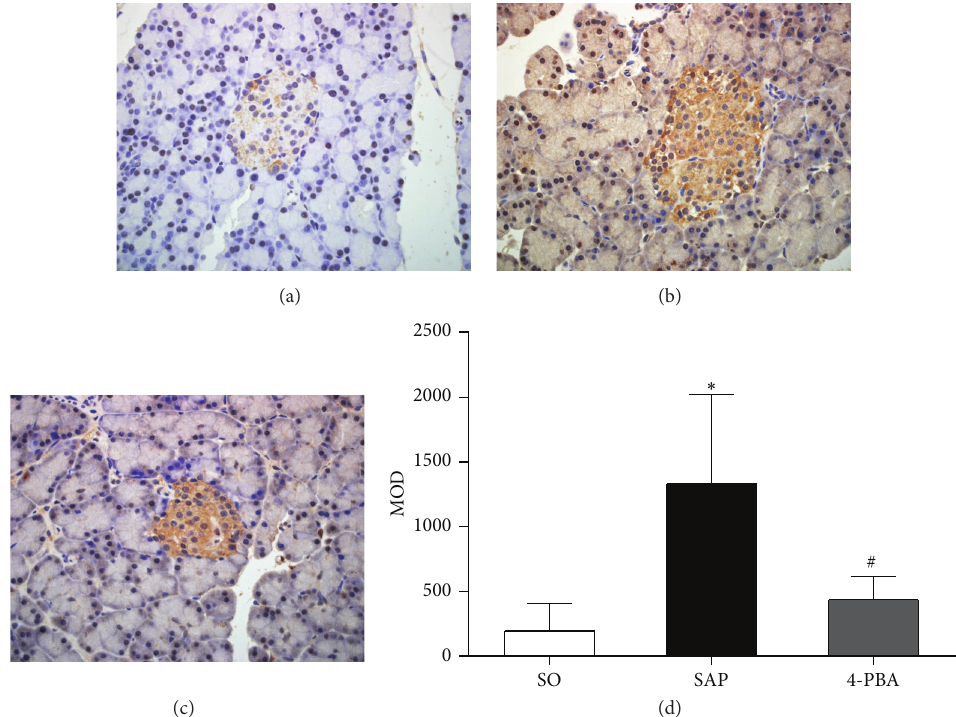
Figure 9: Immunohistochemical expression of Caspase-3 in pancreatic islets (original magnification, × 400). (a) SO group; (b) SAP group; (c) 4-PBA group. (d) Comparison of MOD of Caspase-3 in all groups. Each value represents the mean ± standard deviation. ∗ 𝑃 < 0.05 versus SO group; # 𝑃 < 0.05 versus SAP